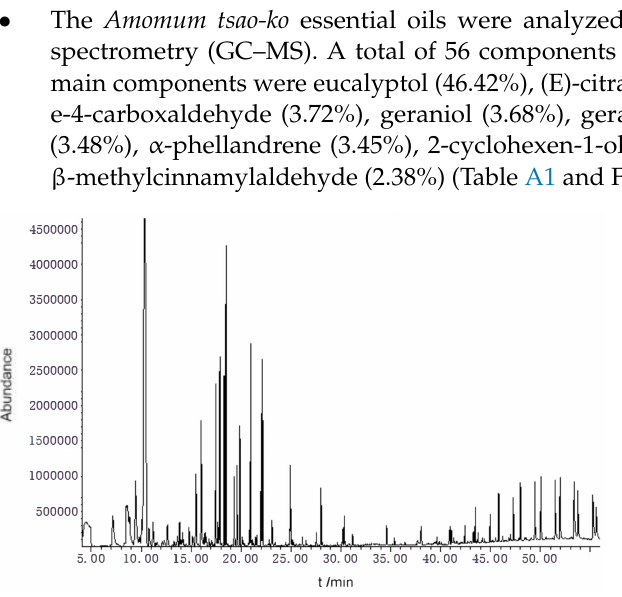
Figure 1. TIC diagram of Amomum tsao-ko essential